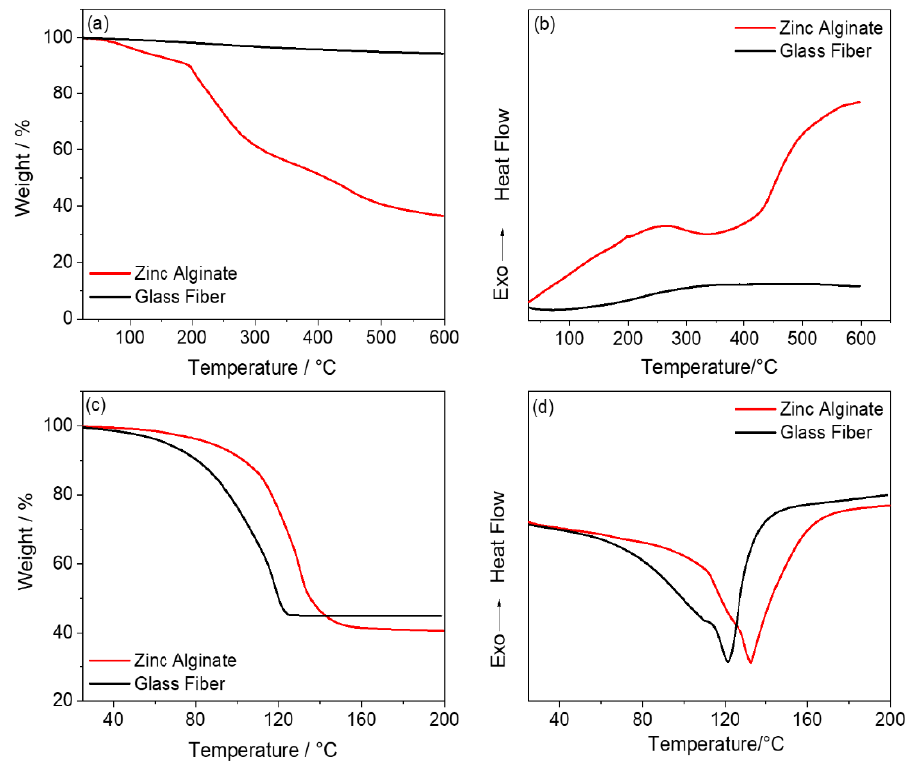
Figure 3. ( a ) Thermogravimetric (TG) and ( b ) differential thermal analysis (DTA) curves of the ZA membrane and the glass-fiber separator, ( c ) TG and ( d ) DTA curves of ZA membrane and the glass- fiber separator saturated with ZnSO 4 electrolyte.